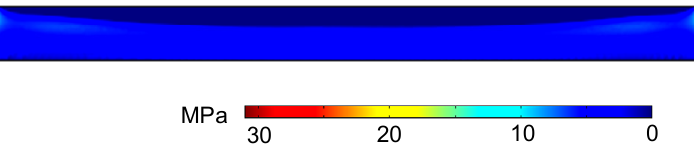
Figure 7. Contact pressure distribution of the CMI with NiW.